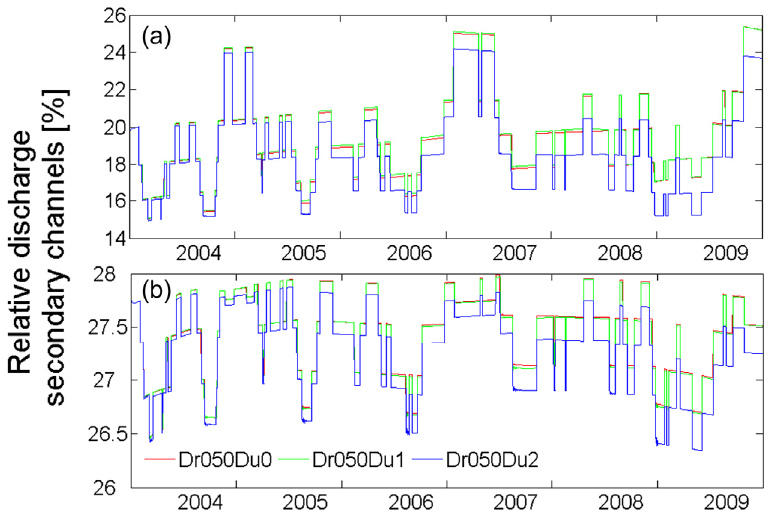
Figure 10. Time-series of relative discharge ( a ) in the secondary channel near Bella Vista, and ( b ) in the secondary channel near